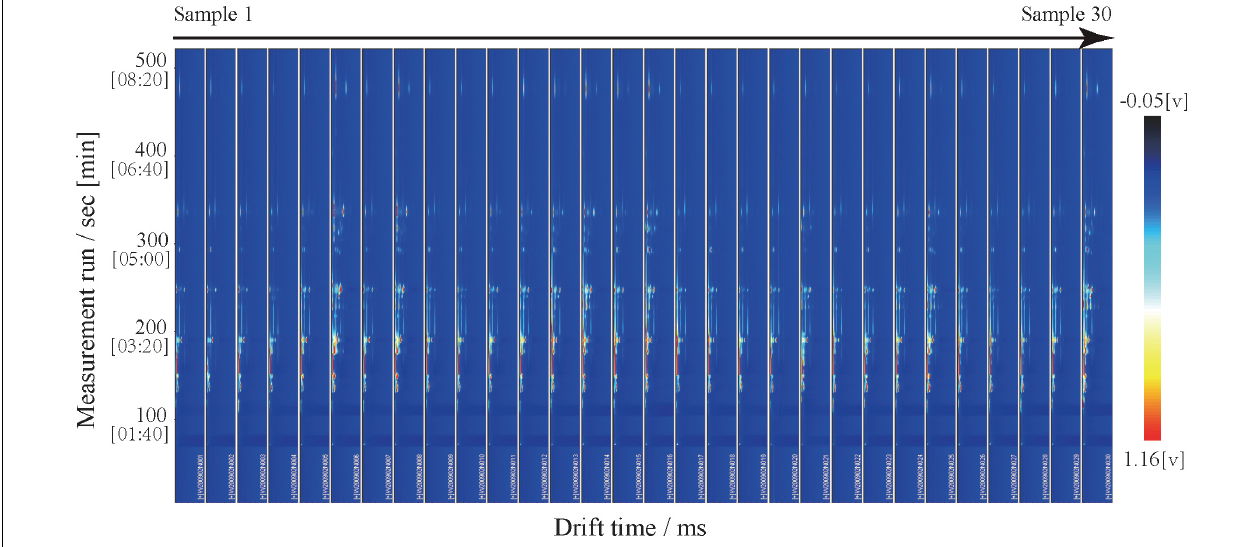
FIGURE 3 | Ion migration spectra of Dongxiang tribute mutton.